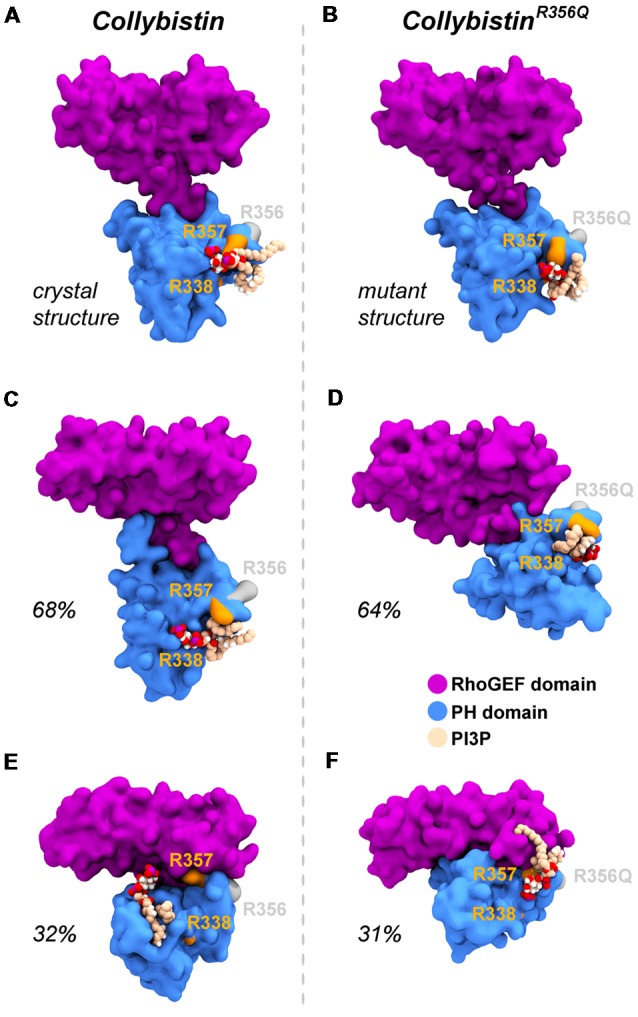
Wild-type collybistin and collybistinR356Q adopt two distinct conformations in solution with unique PI3P binding sites. PI3P (shown in space-fill representation, colored by atom where carbon = tan, oxygen = red, nitrogen = blue, hydrogen = white and phosphorous = purple) is docked to wild-type collybistin (A) and collybistinR356Q
(B) structures (collybistin is shown as a purple and blue surface). Representative collybistin conformations and PI3P binding poses from the most frequently adopted conformations during molecular dynamics simulations are shown in panels (C–F). A 2.5 Å cut-off distance was used to perform the cluster analysis and the proportion of the simulation that each conformation represents is labeled. Key arginine residues R338, R357 and R356 are colored orange (R338 and R357) and gray (R356).